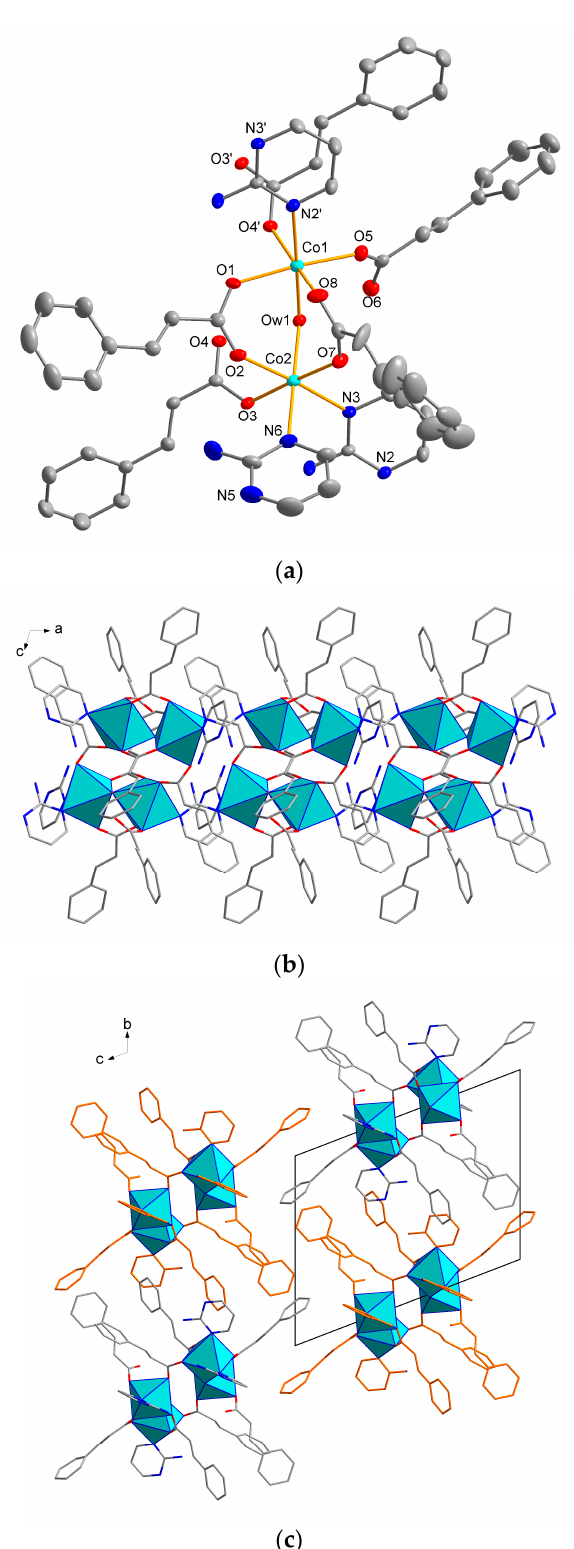
Figure 1. ( a ) Displacement ellipsoids of the molecular structure of 1 , drawn at a 30% probability level. The hydrogen atoms are omitted for clarity. The carbon, oxygen, nitrogen, and cobalt atoms are shown as gray, red, blue, and cyan spheres, respectively. ( b ) A chain of 1 is formed along the a-axis. The cyan polyhedra represent the cobalt atoms. ( c ) A view of the interlayer packing in 1 . Two bonding colors are shown to simply distinguish the different chains.